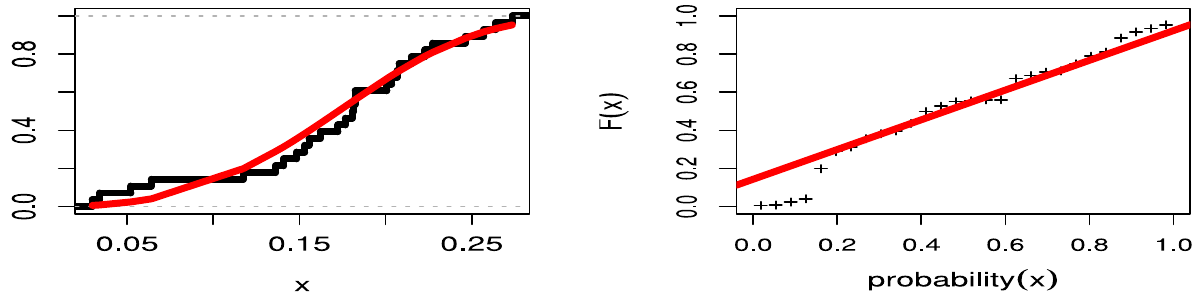
Figure 10. The CDF plot with empirical line and PP plot for the United Kingdom data set.